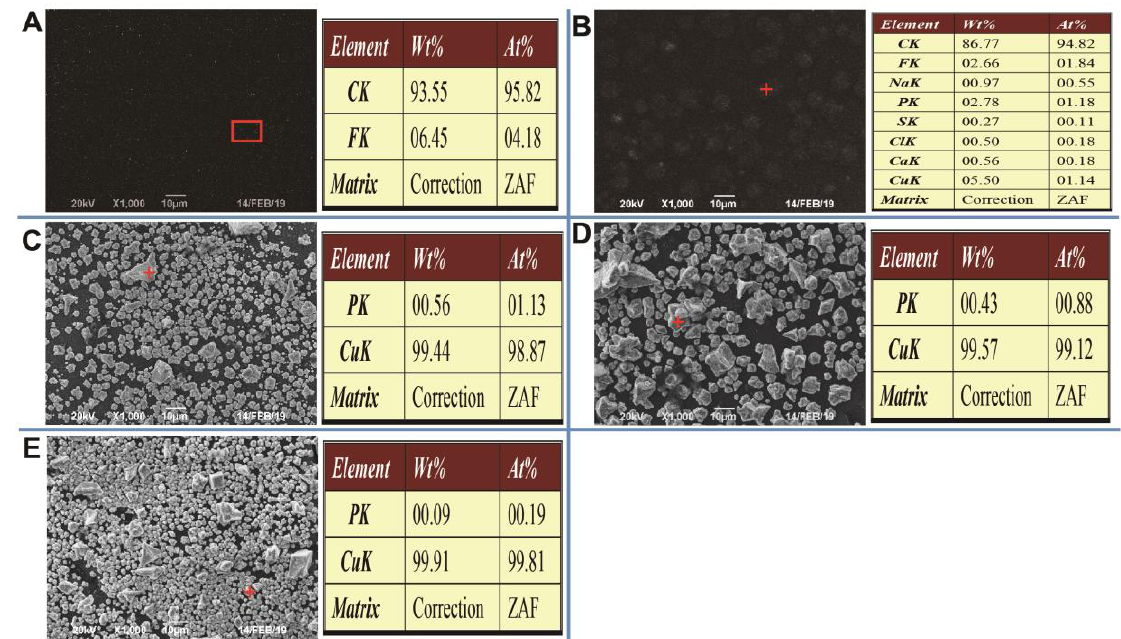
Figure 9. SEM pictures and EDS analysis of the cathodes of MFCs after the treatment of simulated AMD. ( A : abiotic; B : glucose; C : acetate; D : ethanol; E : lactate).